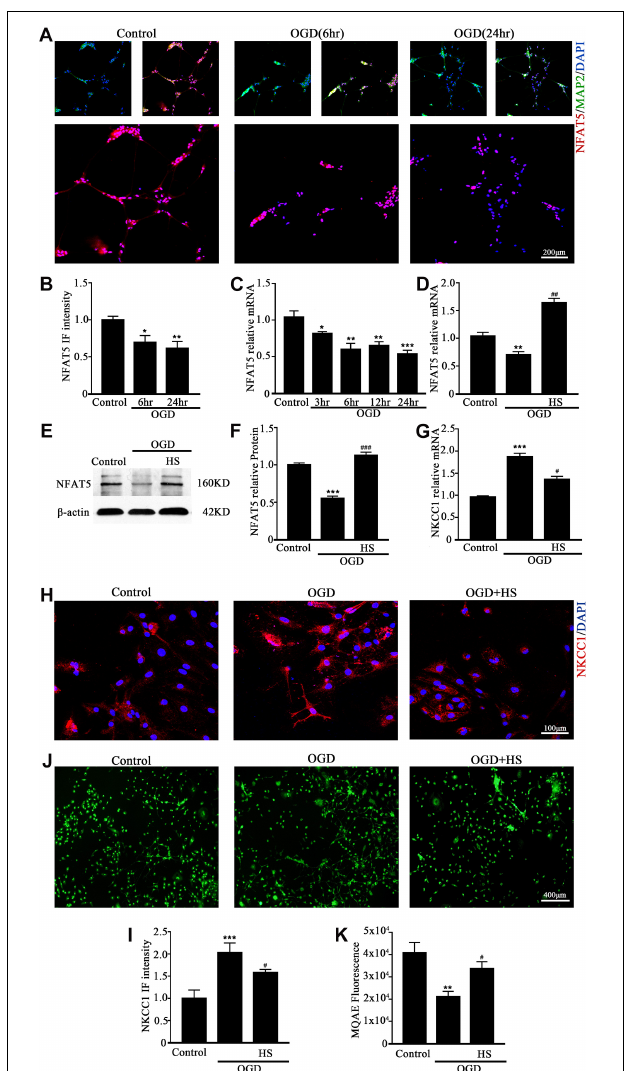
FIGURE 3 | HS treatment inhibited NKCC1 expression. (A) Confocal images showing expression of NFAT5 in neurons. (B) The intensity of NFAT5 fluorescence was determined in 10 fields/well and divided by the number of cells counterstained with DAPI. (C) NFAT5 mRNA expression level at 3, 6, 12, and 24 h after OGD. (D) Graphical representation of the fold changes of NFAT5. HS (100 mM) treatment increased NFAT5 expression compared to OGD. (E) The protein expression level of NFAT5 examined in Control, OGD and HS groups. (F) Quantification of independent blots. (G) NKCC1 mRNA expression level after treatment with HS. (H) Confocal image demonstrating NKCC1 expression in neurons after treatment with HS (100 mM). (I) The intensity of NKCC1 was determined in 10 fields/well and divided by the number of cells counterstained with DAPI. (J,K) Fluorescence imaging of Cl − via MQAE staining in neurons. The green fluorescence indicates the intensity of MQAE. The values represent the mean ± SEM. ∗ p < 0.05, ∗∗ p < 0.01, ∗∗∗ p < 0.001 versus control (Tukey’s test after one-way ANOVA). # p < 0.05, ## p < 0.01, ### p < 0.001versus OGD (Tukey’s test after one-way ANOVA).